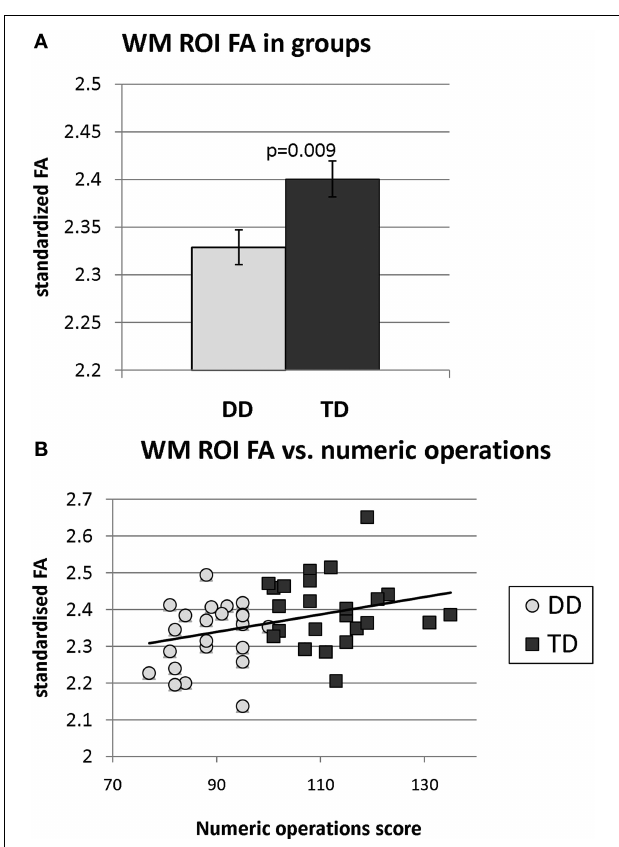
FIGURE 5 | (A) Fractional anisotropy (FA) within right temporal-parietal regions that showed white matter defi cits in DD children. FA was signifi cantly reduced in children with DD, compared to TD children. (B) Across the two groups, FA was signifi cantly correlated with the Numerical Operations subscore of the